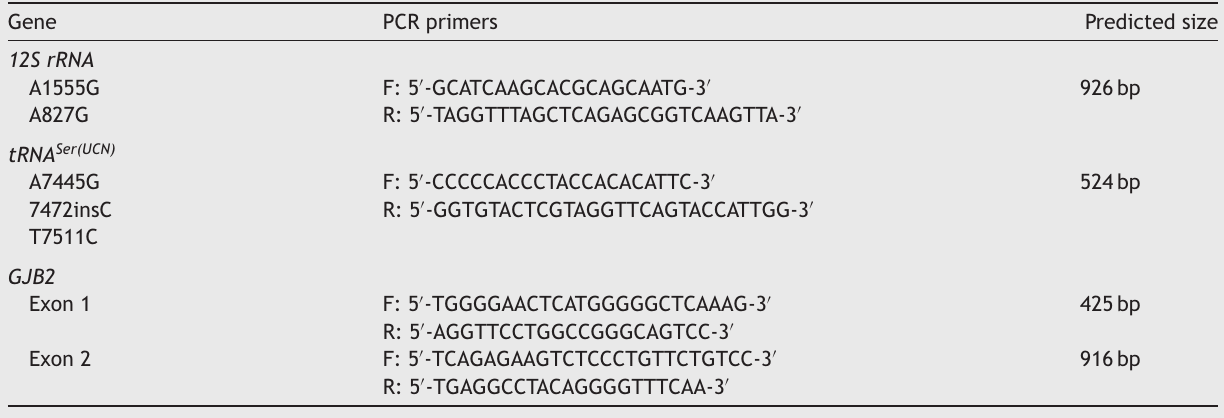
PCR primer sequences.